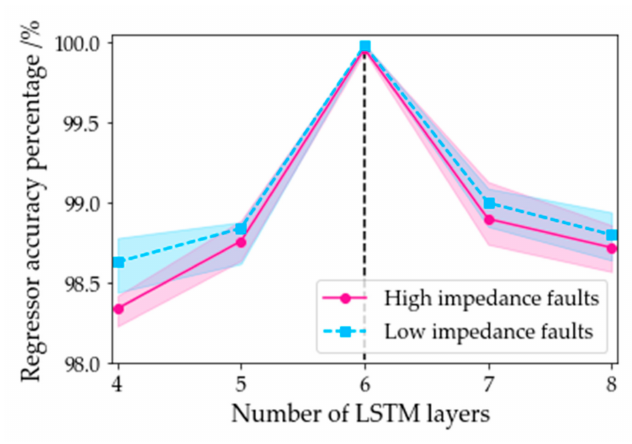
Figure 17. Test results when the number of LSTM layers